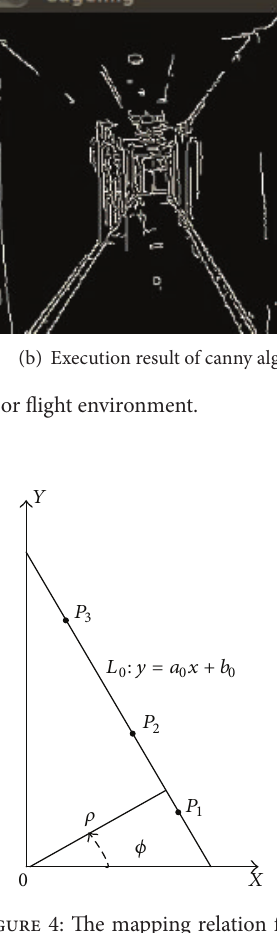
Figure 4: The mapping relation for a line in the image space and parameter